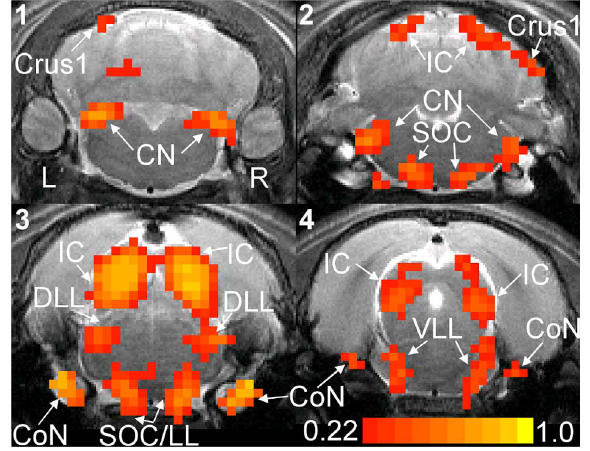
Figure 2. Correlation coefficient map. Correlation coefficient (r) map computed from the average spin-echo echo planar imaging images of a representative animal. Averaging was performed across the seven ILDs. The left and right hemispheres of the brain are labeled. The image slices are labeled one to four and the distances from their centers to Bregma are 10.9, 9.7, 8.5, and 7.3 mm, respectively. Groups of activated voxels with r . 0.22 and in clusters of three voxels are color coded and can be found in the cochlear nerve (CoN), cochlear nucleus (CN), superior olivary complex (SOC), dorsal lateral lemniscus (DLL), ventral and intermediate lateral lemnisci (VLL), inferior colliculus (IC), and crus1 of the ansiform lobule of the cerebellum (Crus1). Regions of interest (ROIs) are drawn around activated voxels in the CN,